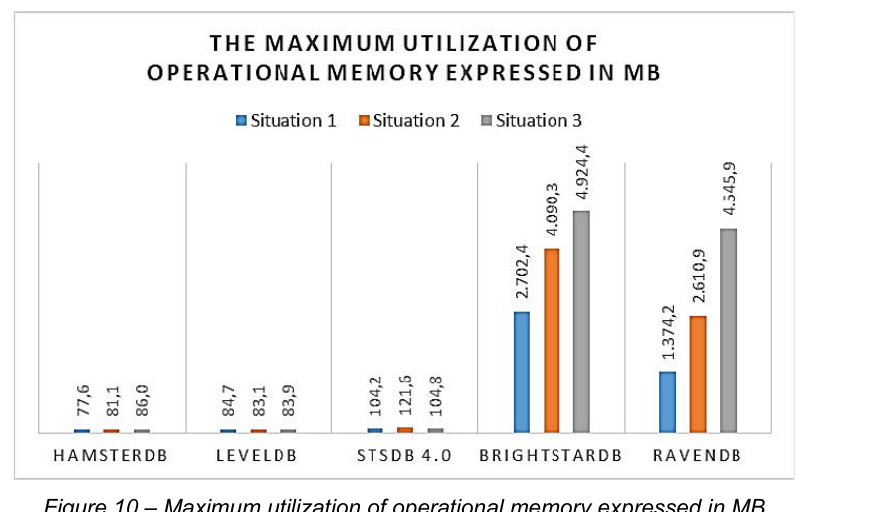
Figure 10 – Maximum utilization of operational memory expressed in MB Рисунок 10 – Максимальное использование оперативной памяти , выраженное в MB Слика 10 – Максимум искоришћења оперативне меморије изражен у